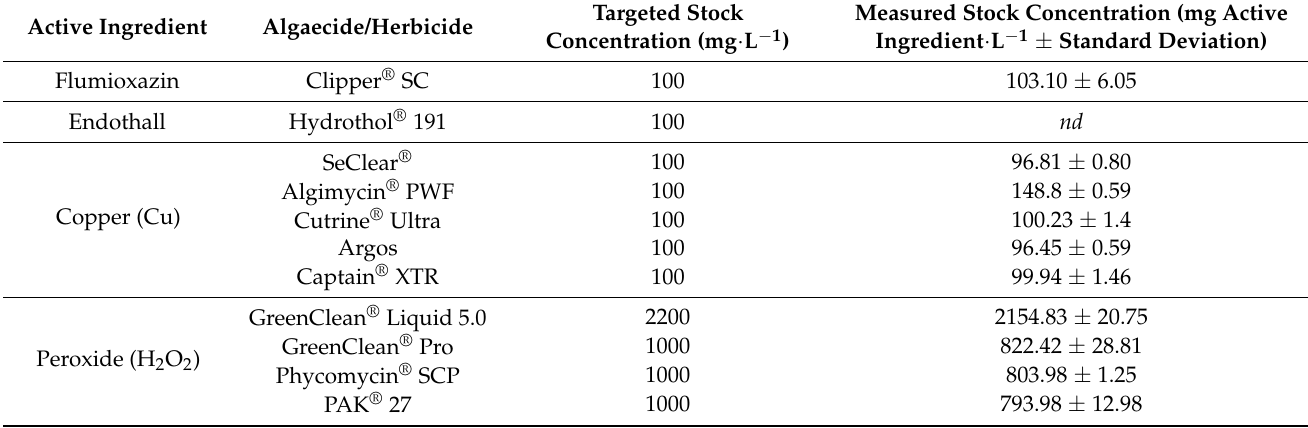
Table 3. Average ( n = 3) measured stock concentrations for each formulation or combination thereof. nd = not